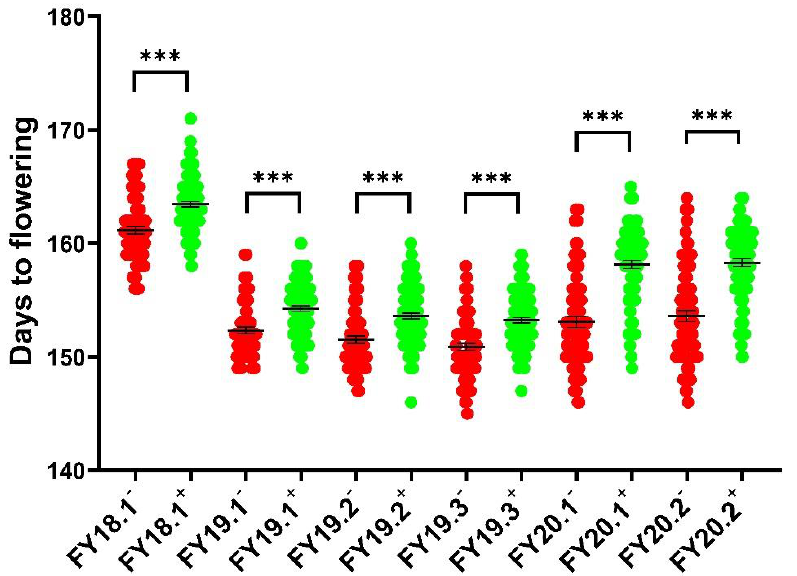
Figure 6. Six replicates of the 158A-SGDH population were analyzed for days to flowering using the InDel marker C2-5 at the cqDTF-C02 locus. − indicates individual plants without cqDTF-C02 locus, + indicates individual plants with cqDTF-C02 locus. Days to flowering were measured as mean ± SEM *** indicates P < 0.001.